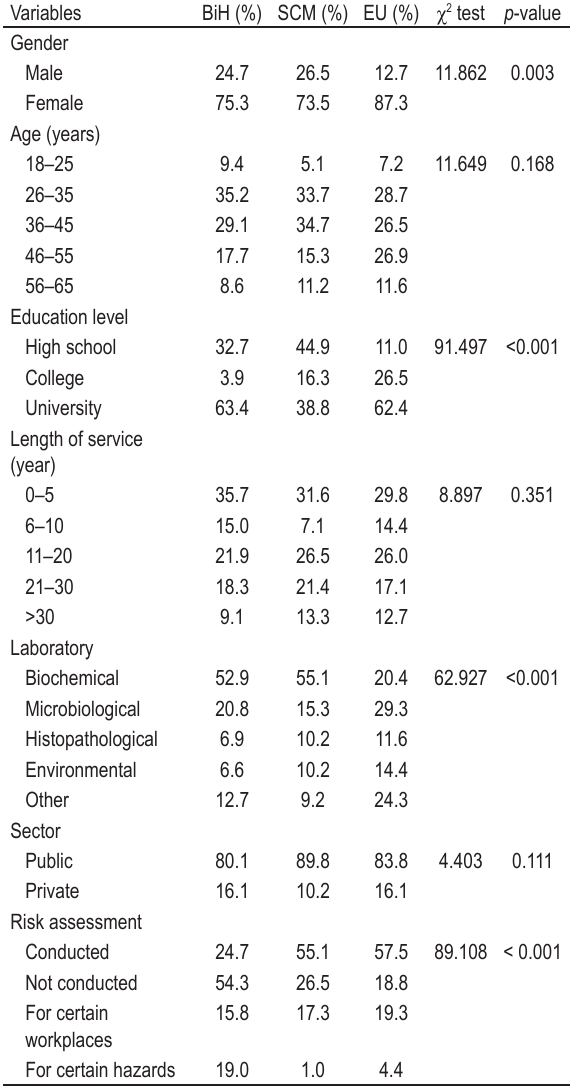
TABLE 1. Sociodemographic characteristics of the respondents